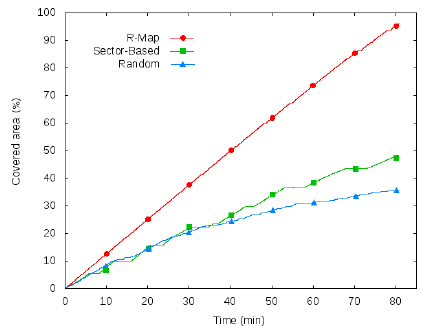
Figure 11. The results of coverage performance according to the path planning method are as follows: The Y axis is the ratio of the coverage area, the X axis is the time (min). The redline is the Rmap scheme, the green line is the sector based algorithm, the blue line is the random algorithm.